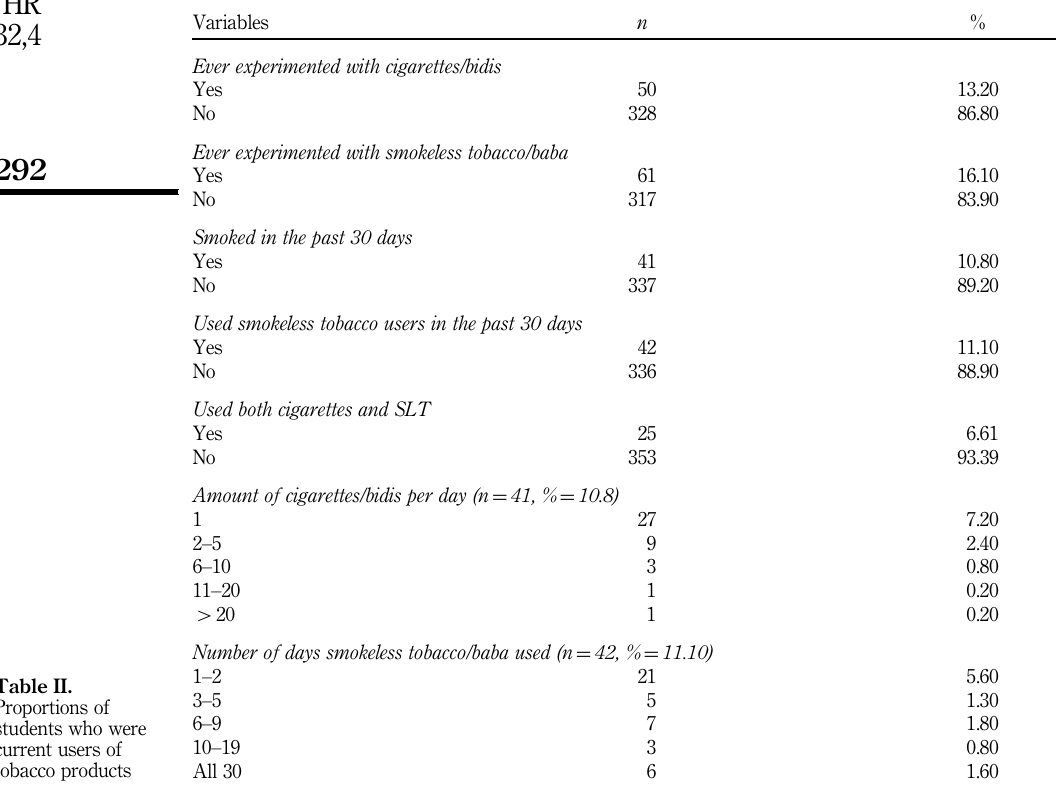
Table II. Proportions of students who were current users of tobacco